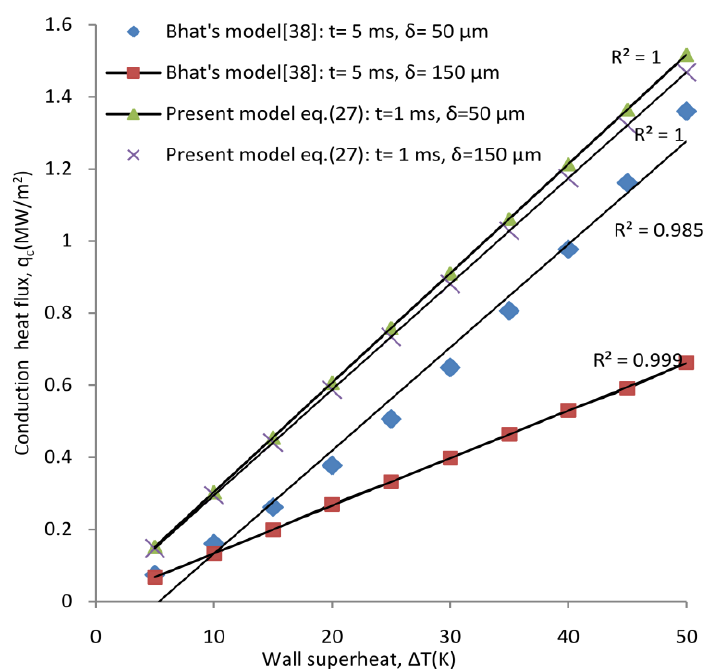
Figure 11. Relative dependence of the conduction heat flux on the wall superheat under constant conditions of time and macrolayer thickness.